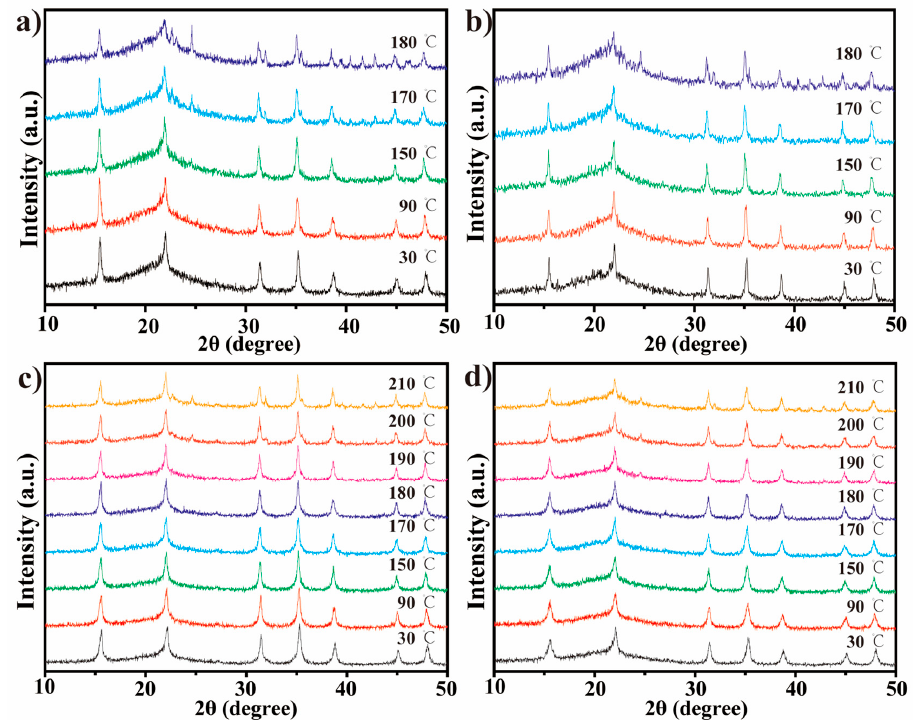
Figure 5. Temperature-dependent Powder XRD test of ( a ) CH 3 NH 3 PbCl 3 PNCs passivated